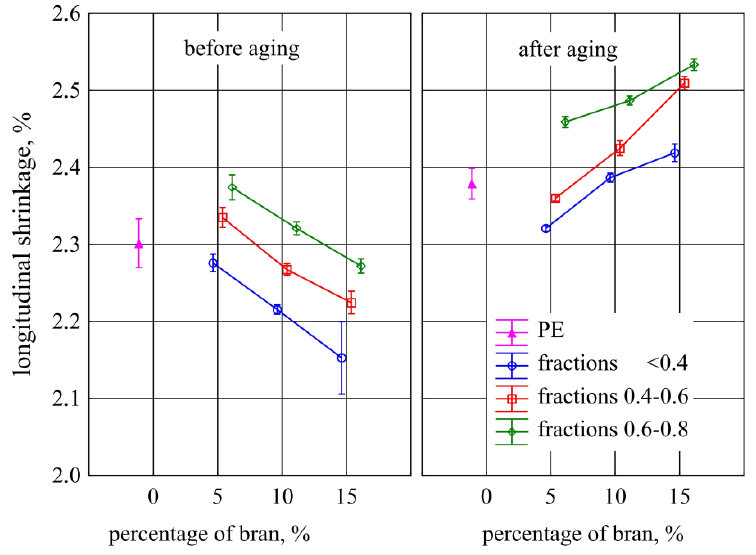
Figure 20. Longitudinal shrinkage of mouldings before and after aging depending on the content and grain size of the introduced bran fraction (average values with standard deviation). grain size of the introduced bran fraction (average values with standard